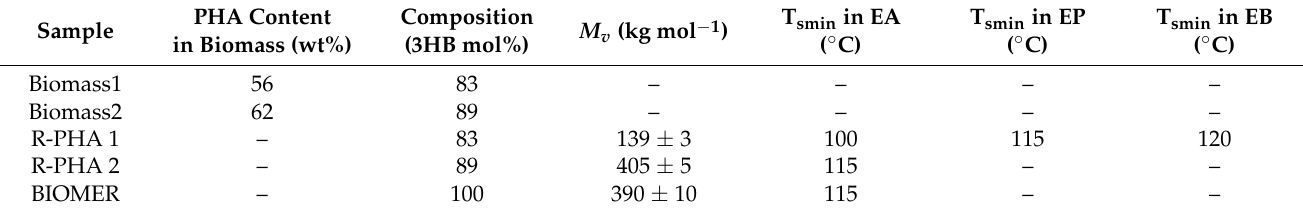
Table 1. Content, composition and viscosity average molecular weight of PHAs in the two biomasses and minimum solubilization temperature (T smin ) of R-PHAs and Biomer in the tested EEs.